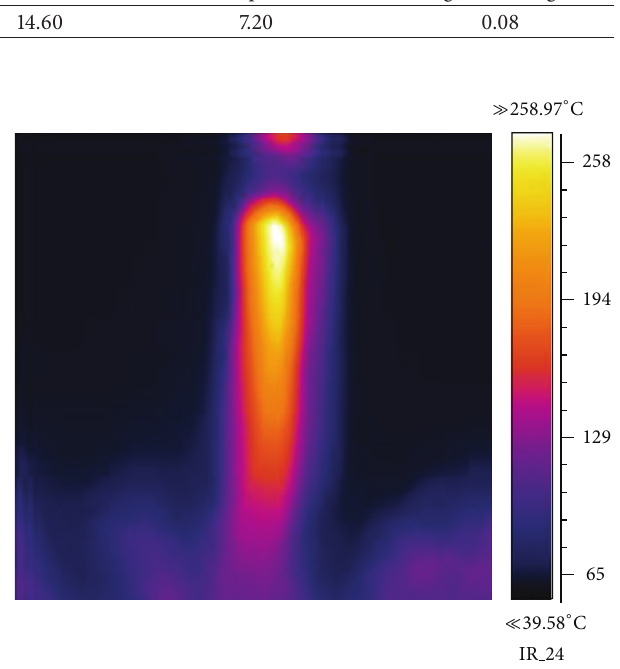
Figure 5: Thermal image of the ROI at 𝑡 = 55 sec.